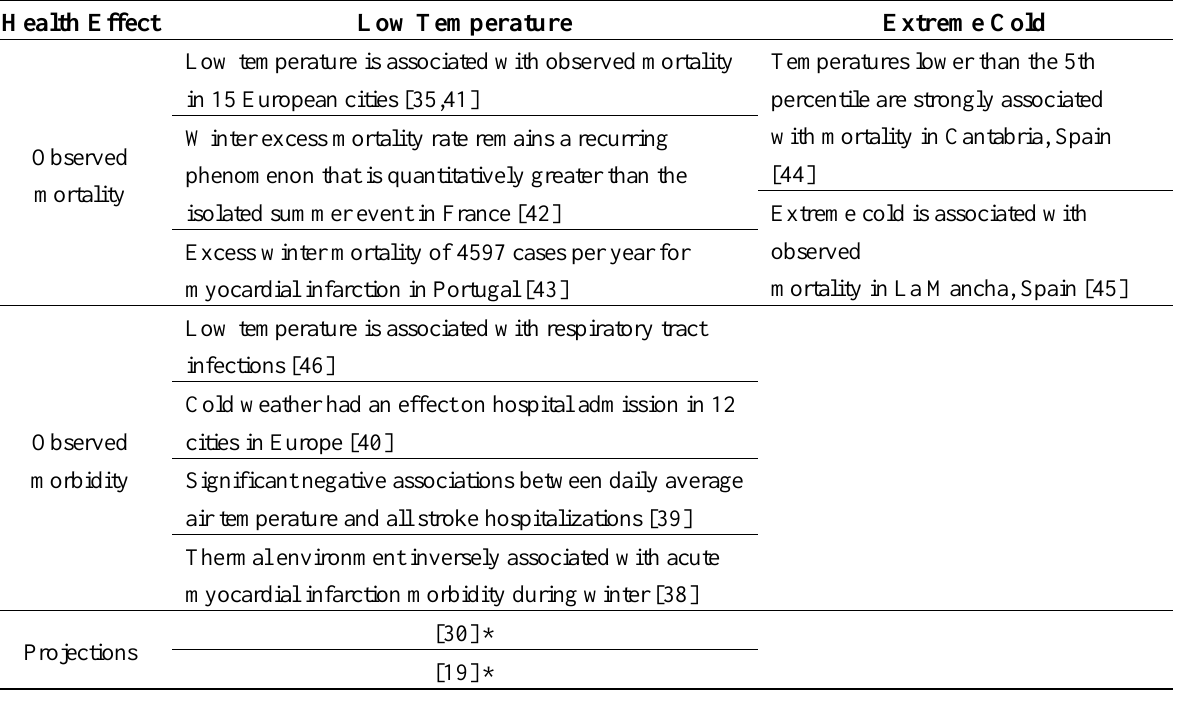
Table 3. Search results about health effects of low temperature